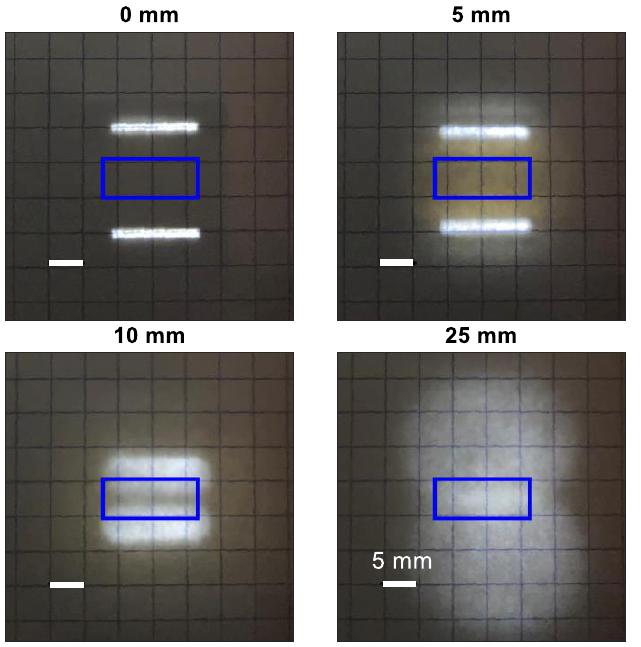
Figure 5. The illumination profile from the fiber bundle at different distances in air. The rectangle indicates the sensitive area of the transducer.